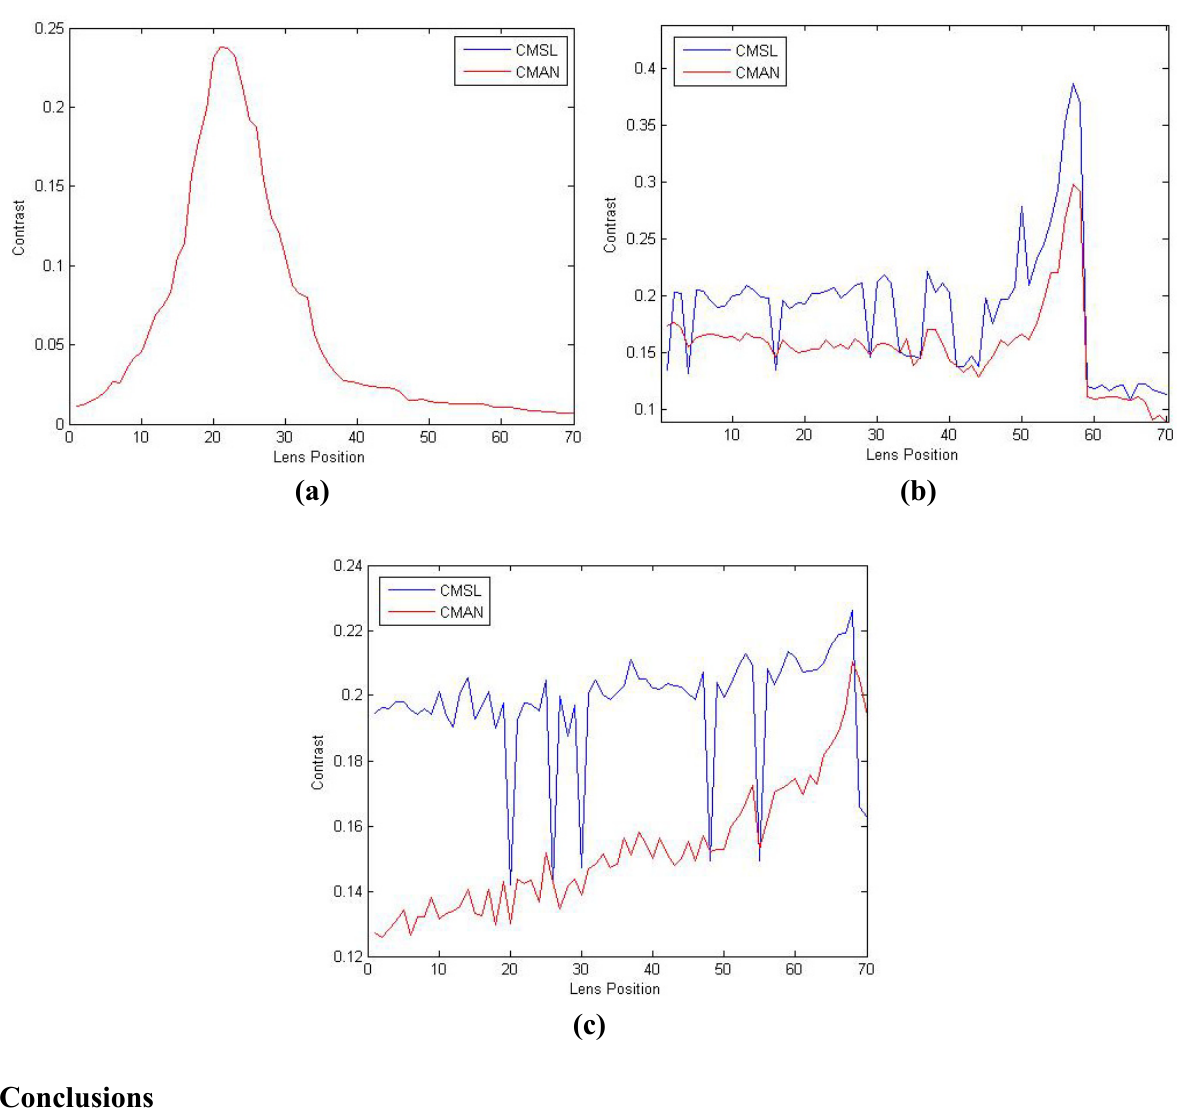
Figure 6. The shape of a low contrast image obtained by CMSL and CMAN (a) under little noise conditions; (b) under adequate noise conditions; (c) under much noise